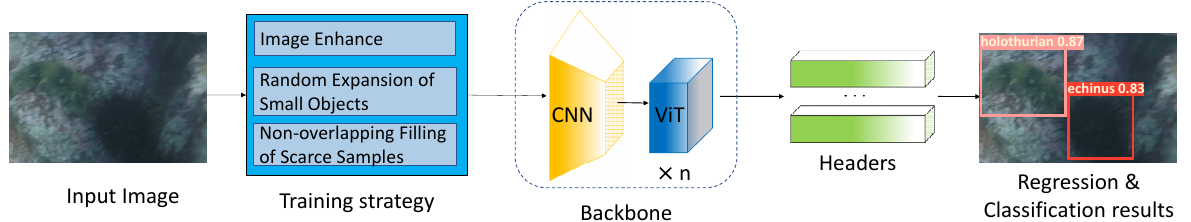
Figure 1. The overall structure of the proposed framework.